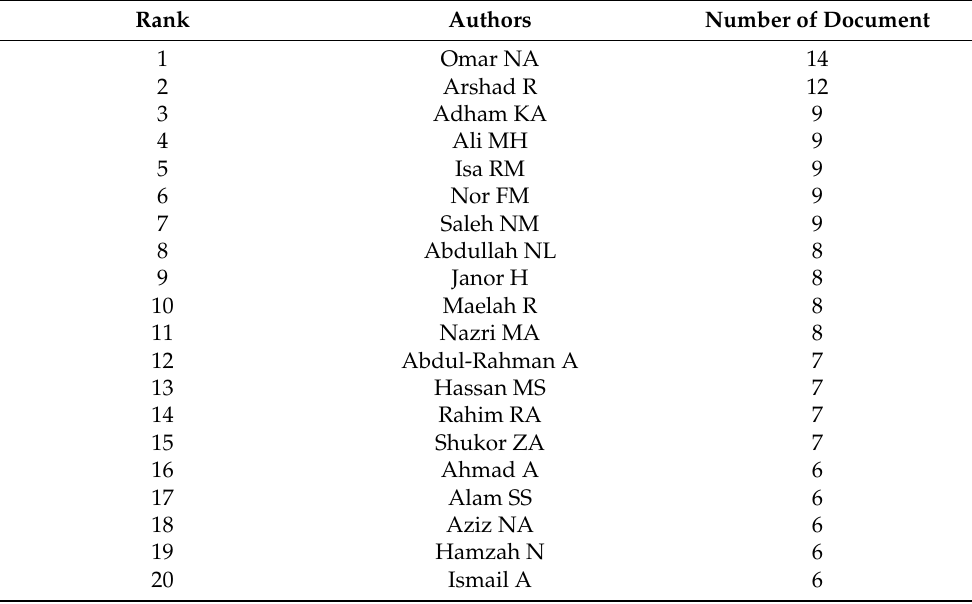
Table 2. Top 20 Authors of Jurnal Pengurusan (2006–2021).